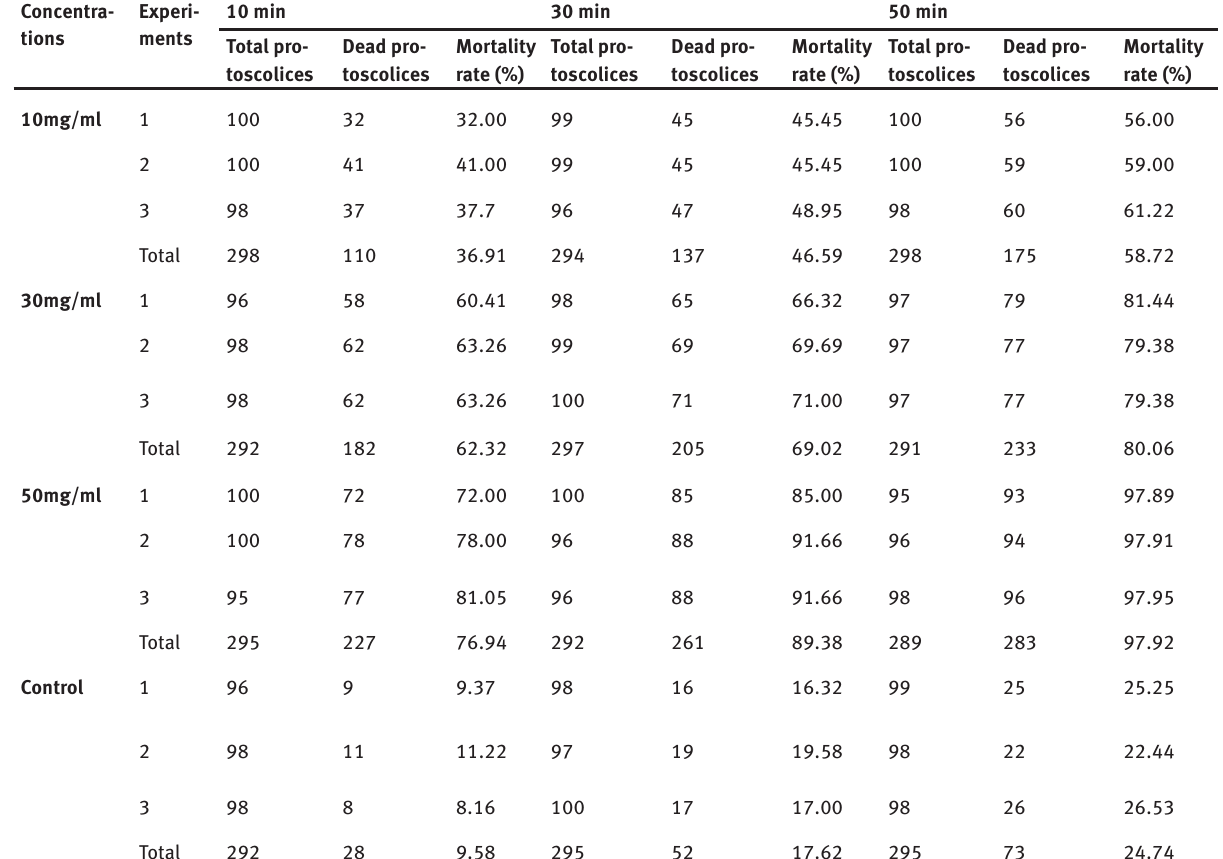
Table 3: Antiprotoscolices effect of B.vulgaris extracts at different concentrations and exposure times. Concentra-